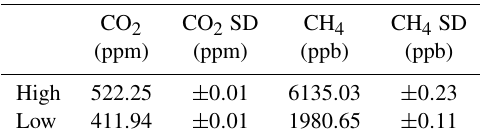
Table 1. Assigned mole fraction of calibration standards used dur- ing the campaign; SD refers to the calibration reproducibility, which is defined as the standard deviation (1 σ ) of the means of at least three independent